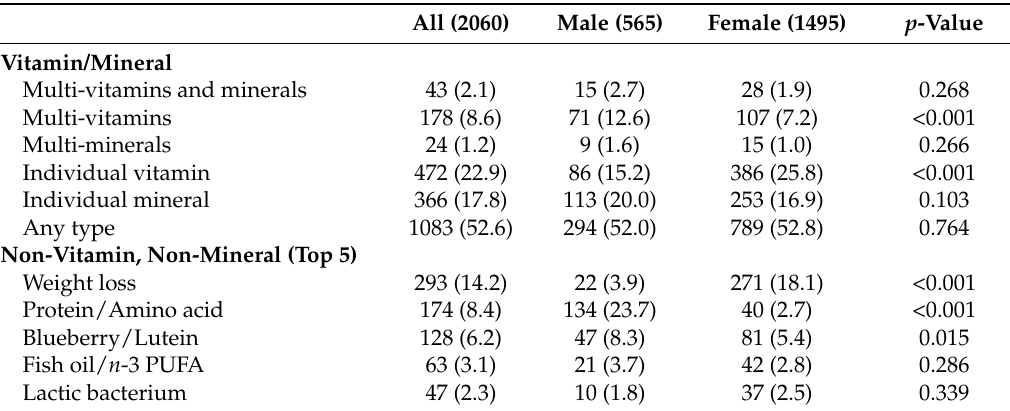
Table 6. Which kind of dietary supplements are you using or did you use? n